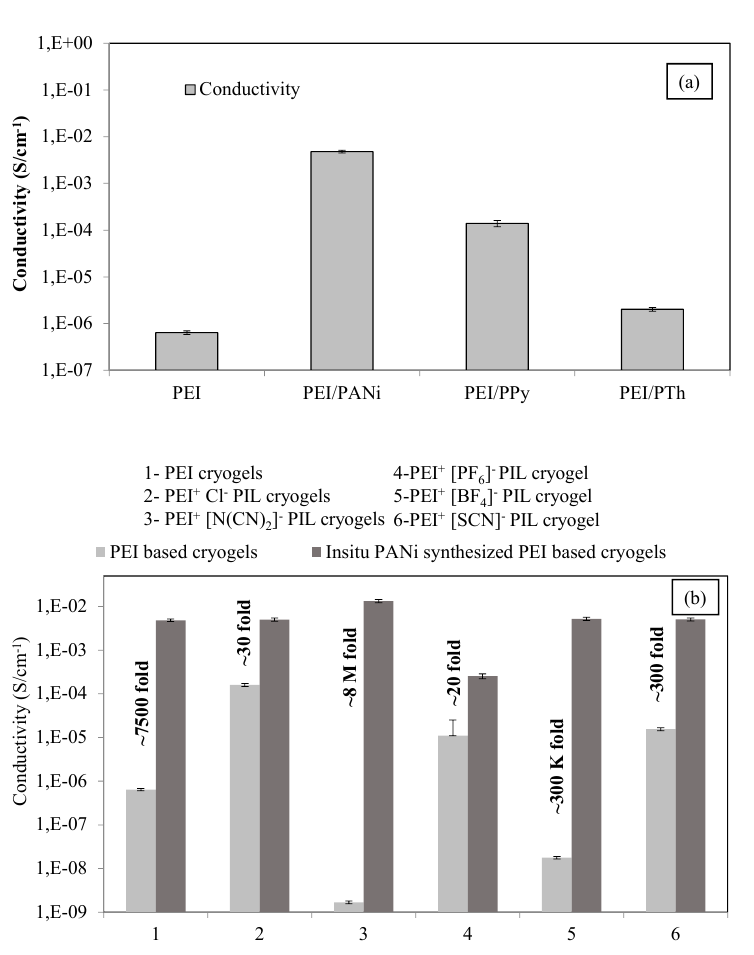
Figure 2. ( a ) Comparison of the measured conductivities of bare PEI cryogel, PEI / PANi, PEI / PPy, and PEI / PTh cryogel composites, and ( b ) PANi containing PEI PIL cryogels composites.